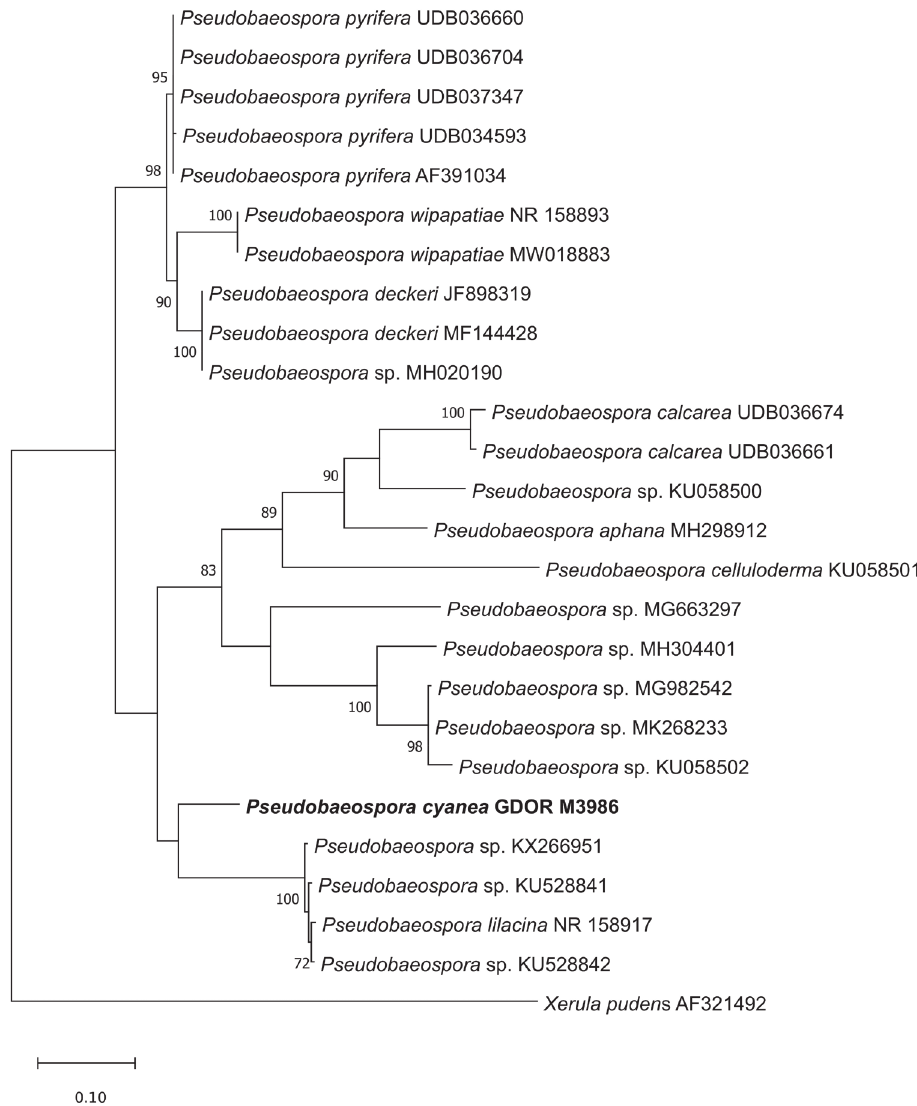
Figure 3. Maximum-likelihood phylogenetic tree with 500 bootstrap replicates, obtained from the ITS sequence alignment of Pseudobaeospora sequences in GenBank. Xerula pudens was used as outgroup